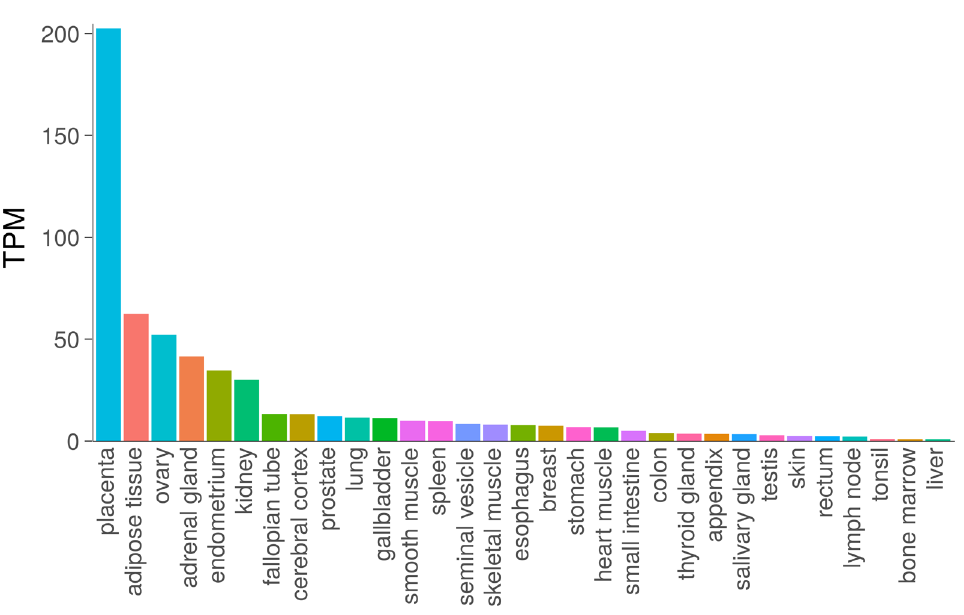
Figure 3. RNA expression of CDKN1C in placenta and different adult human tissues. Data reproduced and modified with permission from the Human Protein Atlas (www.proteinatlas.org) (Uhlen et al. , 2015). TPM = Transcripts Per